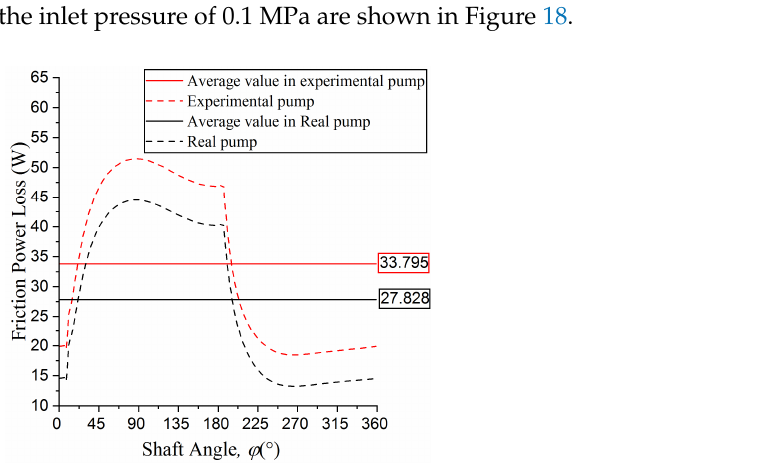
Figure 18. Simulation results of friction power loss of the slipper/swashplate interface.